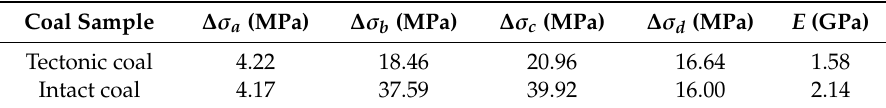
Table 2. Critical stresses of tectonic and intact coal during each stage.